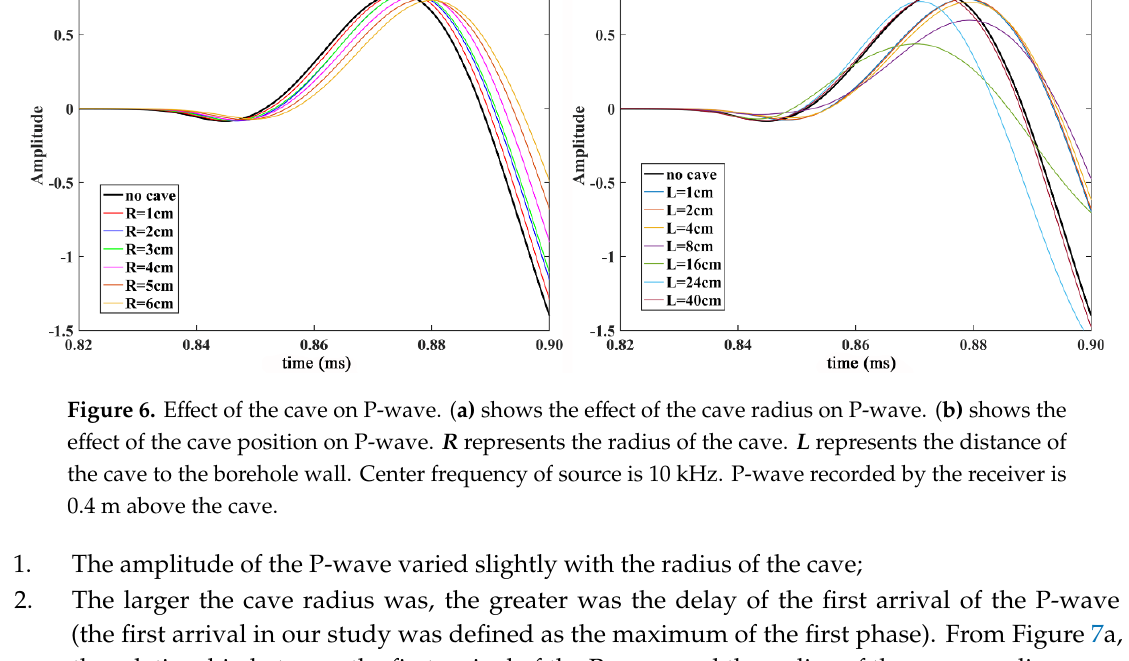
Figure 7. Effect of cave and excitation frequency on the P-wave. ( a , b ) Excitation frequency is 10 kHz. ( c ) Excitation frequency is 7 kHz. R represents the radius of the cave. L represents the distance of the cave to the borehole wall. P-wave recorded by the receiver is 0.4 m above the cave.